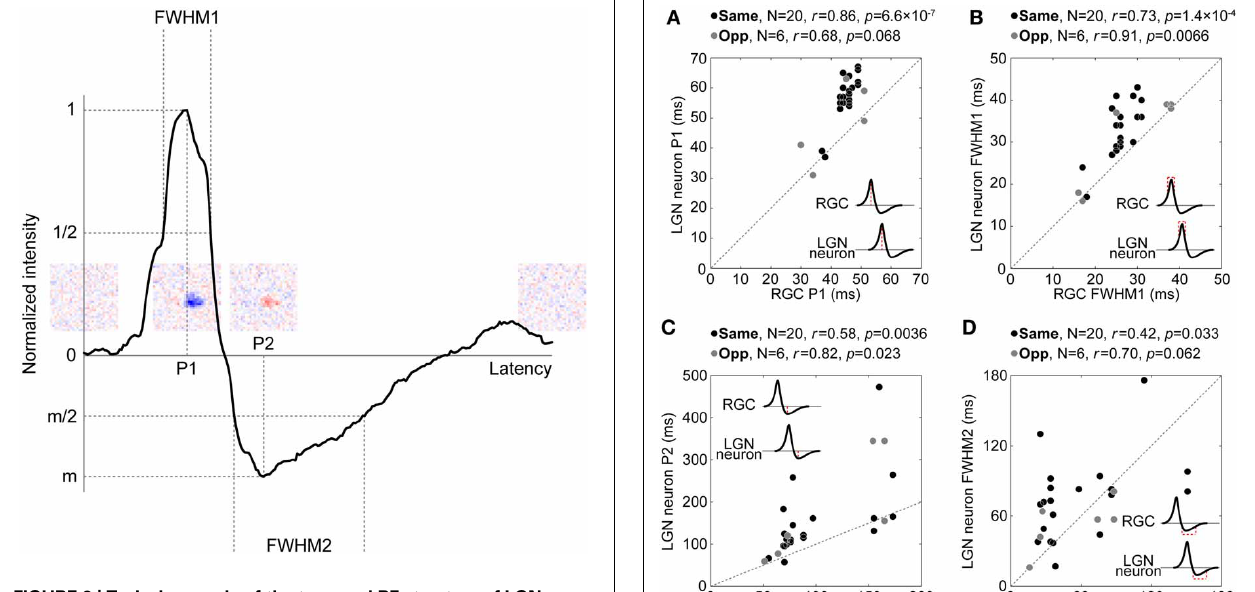
FIGURE 8 | Typical example of the temporal RF structure of LGN neurons. Horizontal and vertical axes indicate latency and normalized intensity of the temporal RF structure, respectively. P1, P2, FWHM1, FWHM2, and m indicate peak latency of the first response, peak latency of the rebound response, duration of the first response, duration of the rebound response, and relative amplitude of the rebound response, respectively. Insets indicate spatial RF structures at latencies of 0, 55 (P1), 96 (P2), 250ms, respectively.